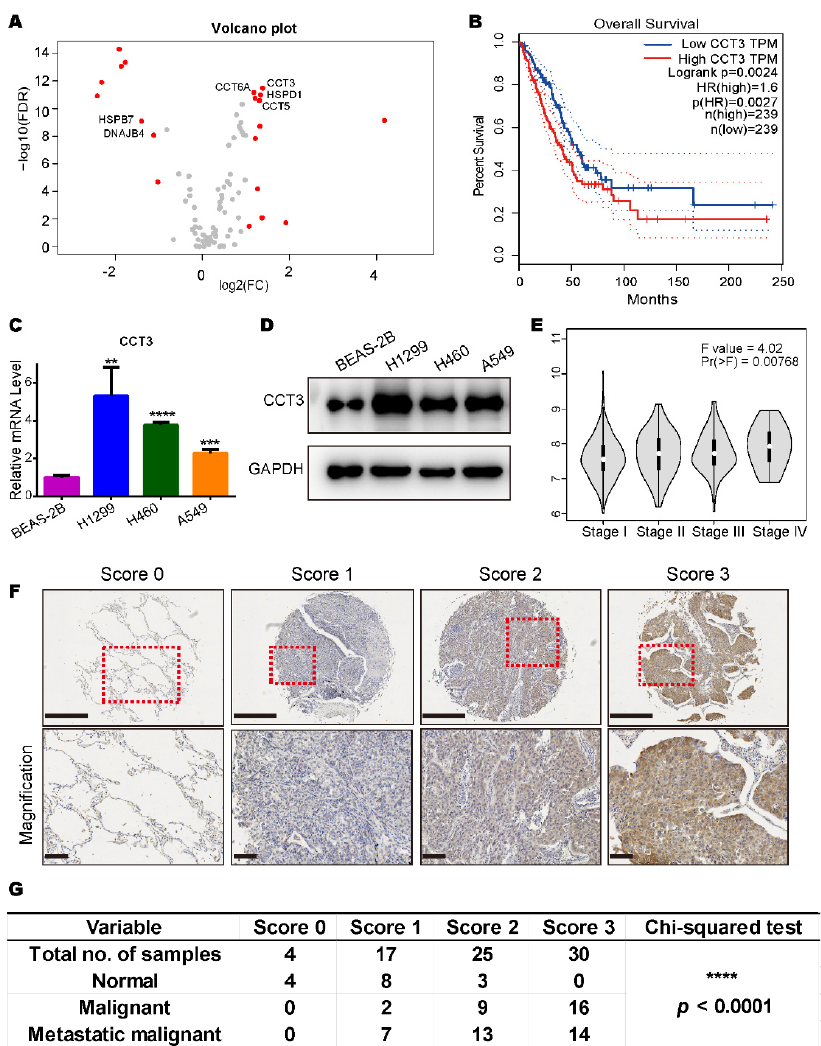
Figure 1. CCT3 is abundantly expressed in lung adenocarcinoma and positively correlated with tumor malignancy. ( A ) Volcano plot of HSP gene expression (535 LUAD tissues vs. 59 normal tissues). Red dots represent genes with |log2 (FC)| > 1 and FDR < 0.05. FC, fold change. FDR, false discovery rate. Raw data were downloaded from TCGA database. ( B ) Kaplan–Meier curve for overall survival of LUAD patients with high or low CCT3 expression. HR, hazard ratio. The plot was created by Gene Expression Profiling Interactive Analysis (GEPIA). Difference was assessed using the log-rank test. The dashed lines represent the 95% confidence interval. ( C , D ) CCT3 mRNA ( C ) and protein ( D ) levels in BEAS-2B, H1299, H460 and A549 cells. Relative mRNA levels of CCT3 were normalized to the mRNA levels of GAPDH. Representative data were from three independent experiments. Data are shown as mean + SD, ** p < 0.01, *** p < 0.001, **** p < 0.0001, two-tailed Student’s t -test. ( E ) Expression levels of CCT3 in different tumor stages of LUAD. The pathological stage plot was made by GEPIA. One-way ANOVA was employed to analyze the differences in gene expression in different stages of LUAD. ( F ) Representative images of the protein levels of CCT3 in the lung tissues with the corresponding IHC scores. Tissues were scored based on the staining intensity. The red dashed boxes represent the amplified views. Upper image scale bar = 500 μ m, lower image scale bar = 100 μ m. ( G ) Scores represent the IHC staining intensity of CCT3 in ( F ). 0 = negative, 1 = low positive, 2 = positive and 3 = high positive. The chi-squared test was used to evaluate the association among the categorical variables. **** p < 0.0001.